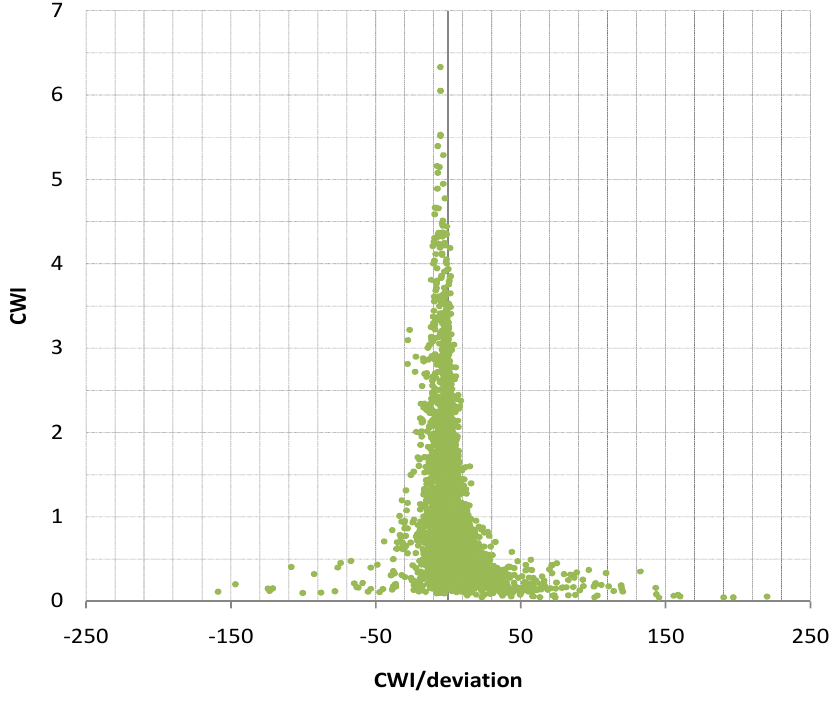
Figure 7. Correlation of CWI and standard deviation for observed